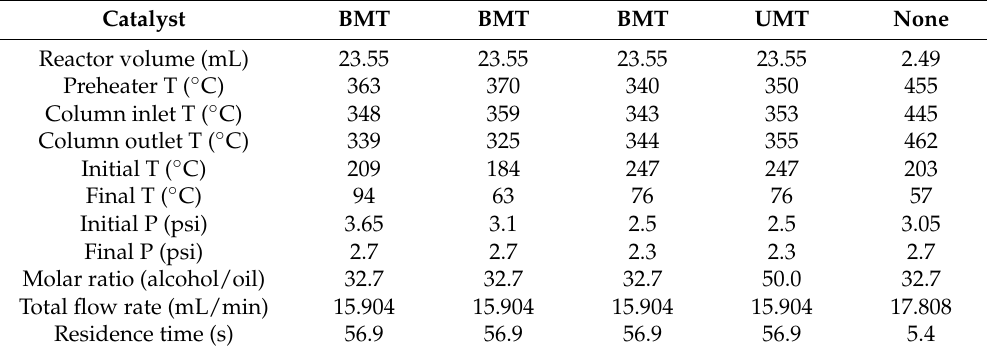
Table 15. Biodiesel production condition for base modified titania